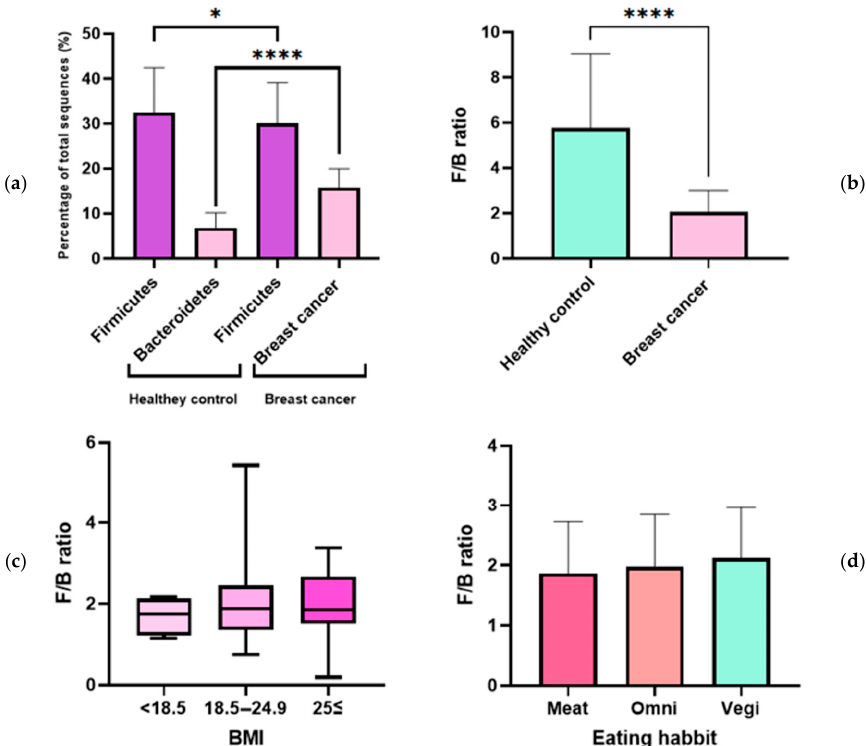
Figure 3. Firmicutes/Bacteroidetes (F/B) ratio in healthy controls and patients with breast cancer. ( a ) Proportion of Firmicutes and Bacteroidetes out of total microbiota in healthy controls and patients with breast cancer. ( b ) F/B ratio in healthy controls and patients with breast cancer. ( c ) The relationship between F/B ratio and body mass index (BMI). BMI in this study was classified according to WHO guidelines (<18.5: Underweight, 18.5–24.9: Normal, 25 ≤ : Overweight or obesity). ( d ) The relationship between F/B ratio and eating habits (Meat: meat-based diet at every meal, Omni: omnivorous, Vegi: vegetarian) * p ≤ 0.05, **** p ≤ 0.0001.